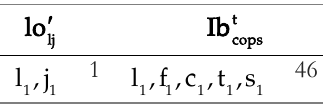
Table 5. Location and capacity of distribution centers and goods transferred from distribution centers to shelters.